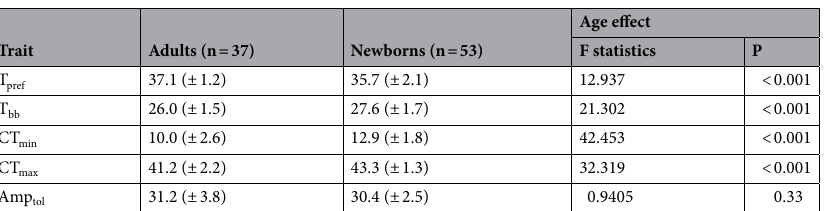
Table 5. Age effect on the thermal physiological traits of Tropidurus torquatus . Amp tol thermal-tolerance range,